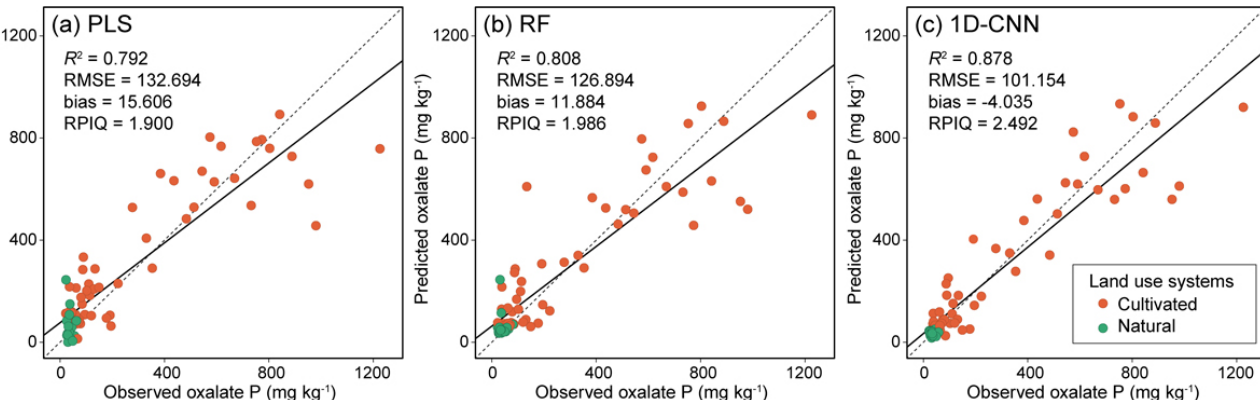
Figure 4. Relationships between observed and predicted values of soil oxalate-extractable P contents with ( a ) partial least squares (PLS), ( b ) random forest (RF), and ( c ) one-dimensional convolutional neural network (1D-CNN) models. RMSE, root mean squared error; RPIQ, ratio of performance to the interquartile range Table 4. Comparison of predictive abilities in the partial least squares (PLS), random forest (RF), and one dimensional convolutional neural network (1D-CNN) models.